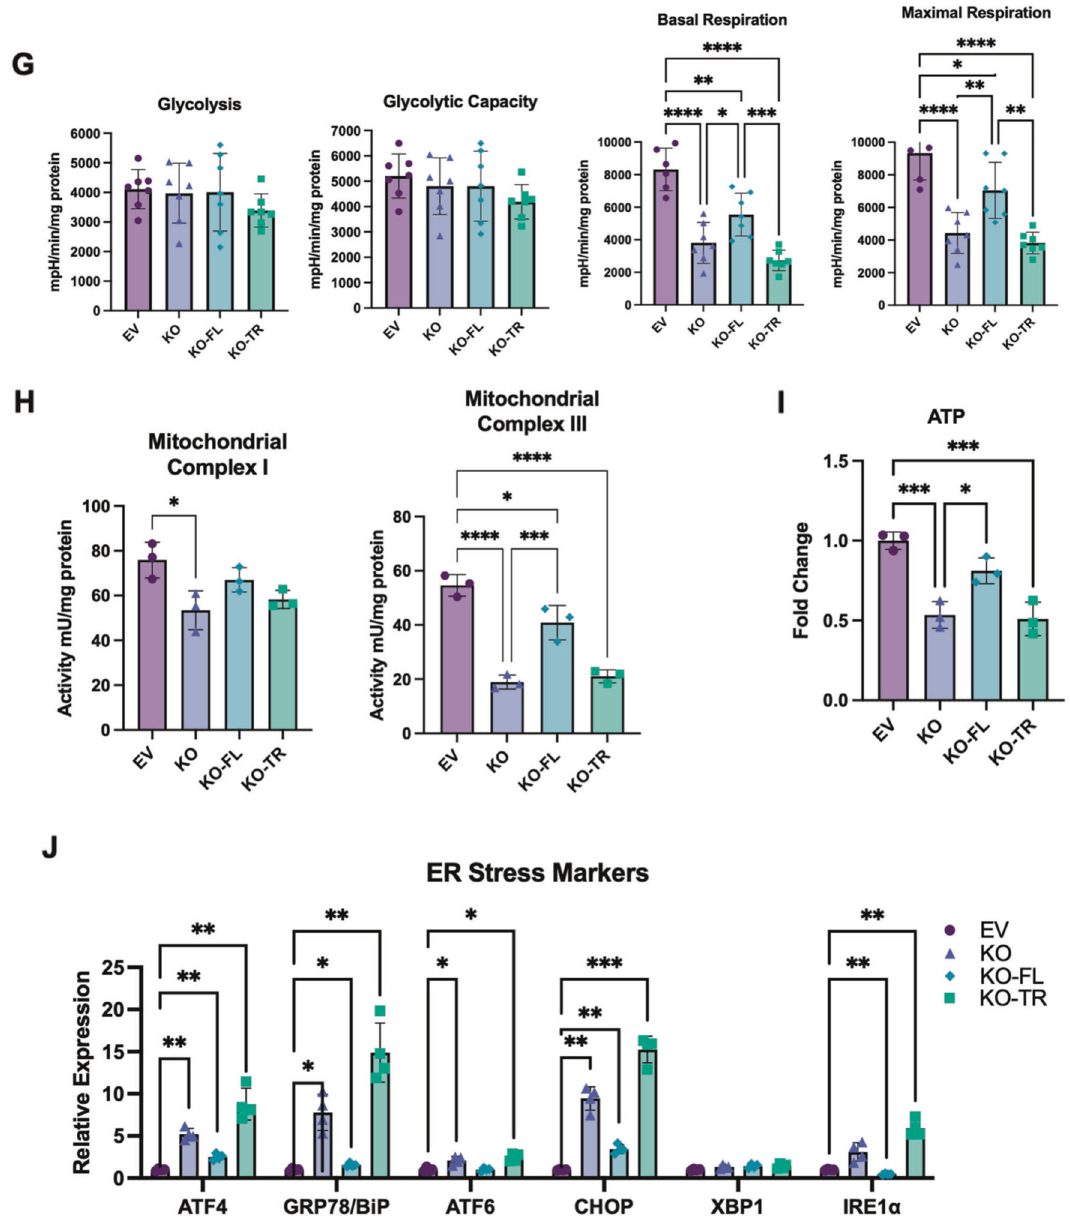
Fig. 6 HKDC1-mitochondria interactions are necessary for mitochondrial function in LC. Using the EV, HKDC1-KO, KO-FL, and KO-TR cells, the following experiments were performed; A cell proliferation assay, B cell proliferation was measured using the BrdU assay, C colony formation assay (left panel images representative of three images per group and right panel number of colonies were counted using Image J software), D in invasion assay 2 × 10 5 cells/well were added to the upper chambers and allowed to invade for 72 h. Invasive cells were stained with 0.1% crystal violet (representative images; left) and were measured by enzyme-linked immunosorbent assay reader using 570 nm as test wavelength (quanti fi cation; right panel), E in vivo tumor growth was assessed where 1 × 10 6 EV or KO or KO-FL or KO-TR cells were inoculated into 4 – 6-week-old male Nu/J mice ( n = 4 – 6), images were taken at endpoint (16 weeks post inoculation), F tumor size was measured weekly till 16 weeks after appearance of tumor with a vernier caliper tumor weight till the end of the study, G seahorse metabolic analysis (ECAR and OCR), H activity assay for mitochondrial complex I (left panel) and complex II (right panel) for each cell lines was also performed, I Intracellular ATP levels relative to EV (fold-change) ( n = 3) and J qPCR analysis to assess mRNA levels of ER stress markers. All cell-line experiments were performed 2 – 3 independent times with at least three replicates per experiments. Values are mean ± SD; * p < 0.05; ** p < 0.01; *** p < 0.001; **** p < 0.0001 by one-way ANOVA (for B – D ) and two-way ANOVA.